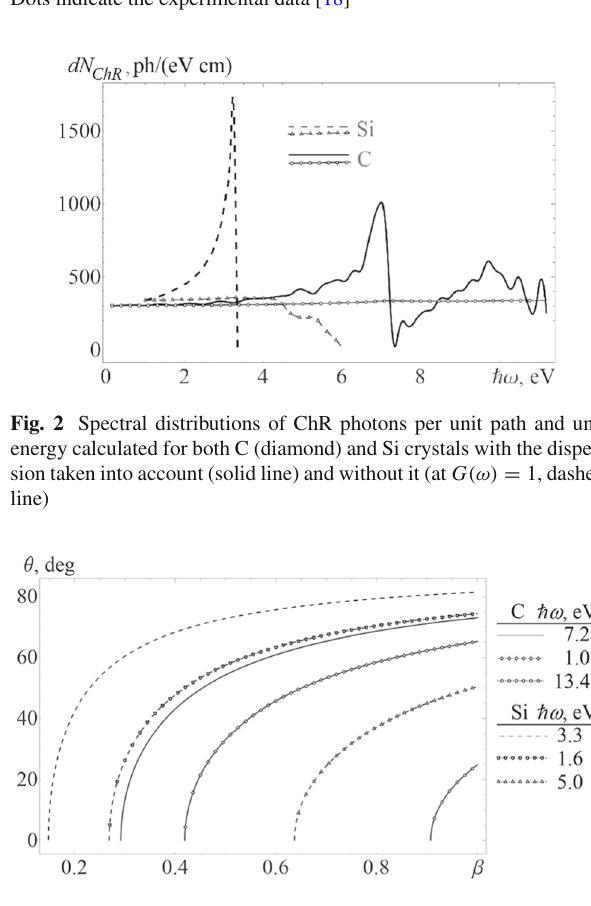
Fig. 3 Dependency of Cherenkov angles θ Ch on particle velocity β = v/ c for both C (diamond) and Si